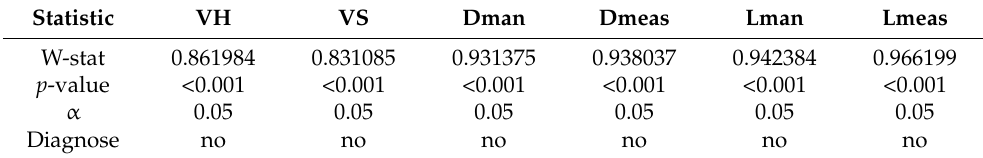
Table A1. Results of normality check for the first experiment